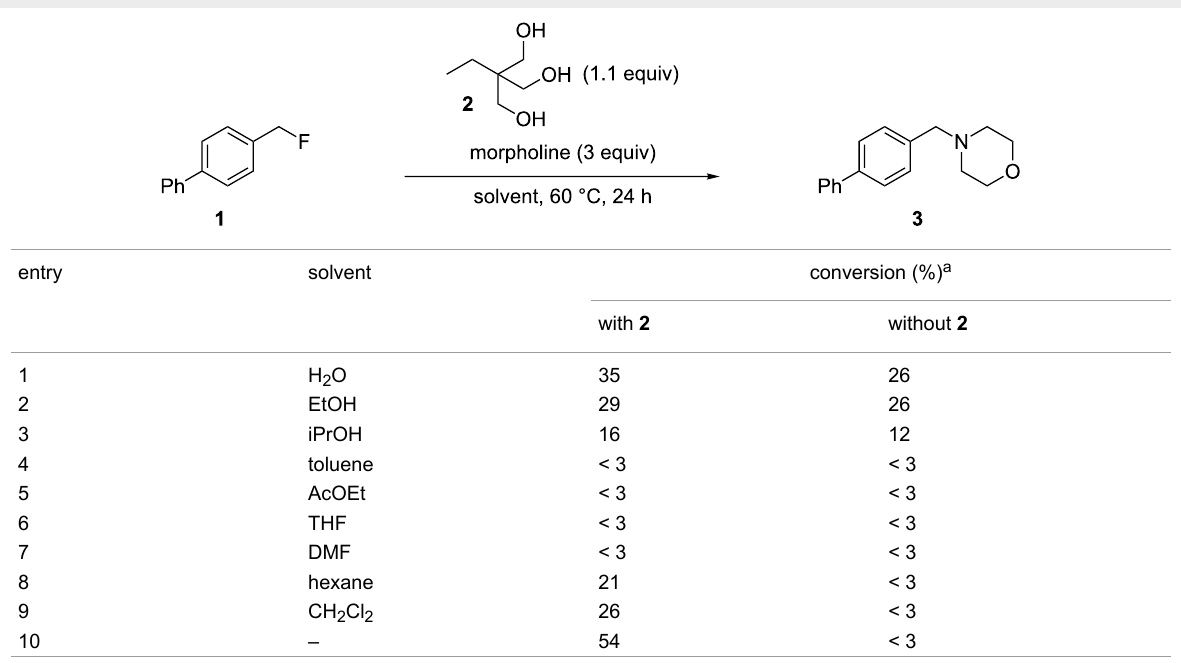
Table 1: Initial screening.